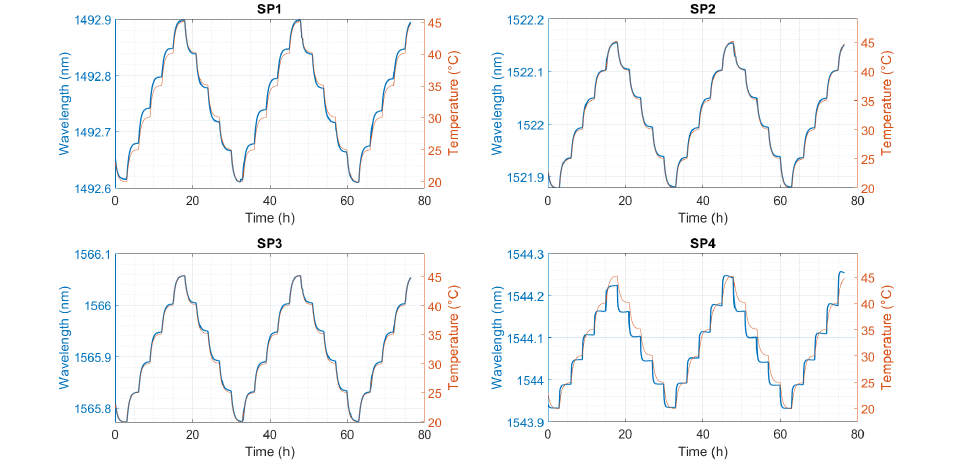
Figure 3. Standard calibration in air; FBG3 from each sensor. SP1: optical fiber in PEEK capillary, single-point mounting; SP2: optical fiber in fused silica tube with polyimide coating, single-point mounting; SP3: optical fiber in fused silica tube, removed polyimide coating, single-point mounting; SP4: optical fiber in fused silica tube, removed polyimide coating, double-point mounting.